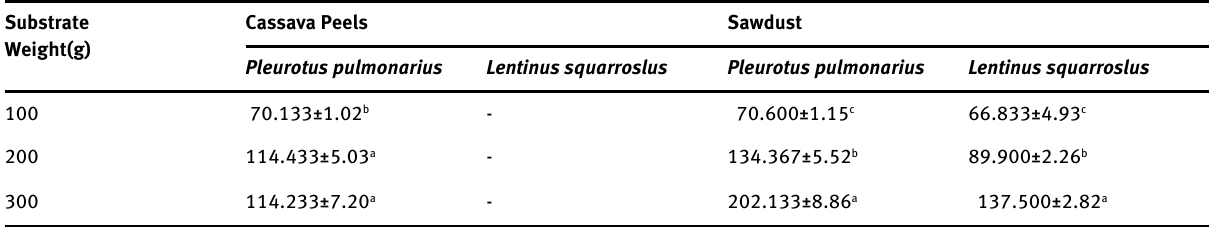
Table 4: Fruit Weight of Sorghum Grains Spawn of Pleurotus pulmonarius and Lentinus squarroslus on Cassava peels and